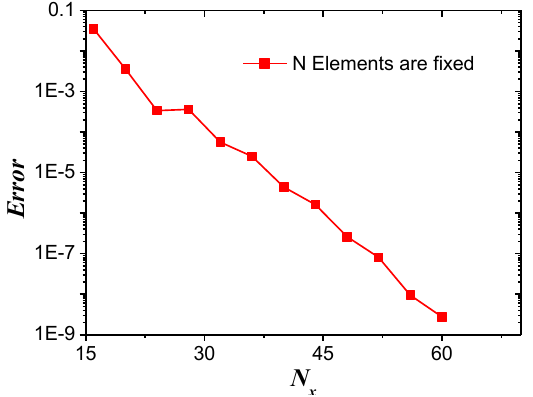
Fig. 5. The error of the reflection of the structure of Fig. 4a) versus total number of nodes along axis x